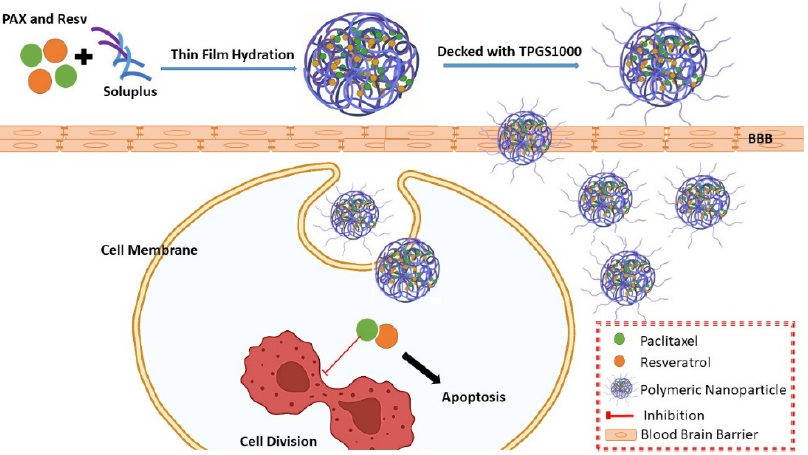
Figure 1. Schematic representation of the PAX-RESV loaded PNPs for anti-glioma activity.